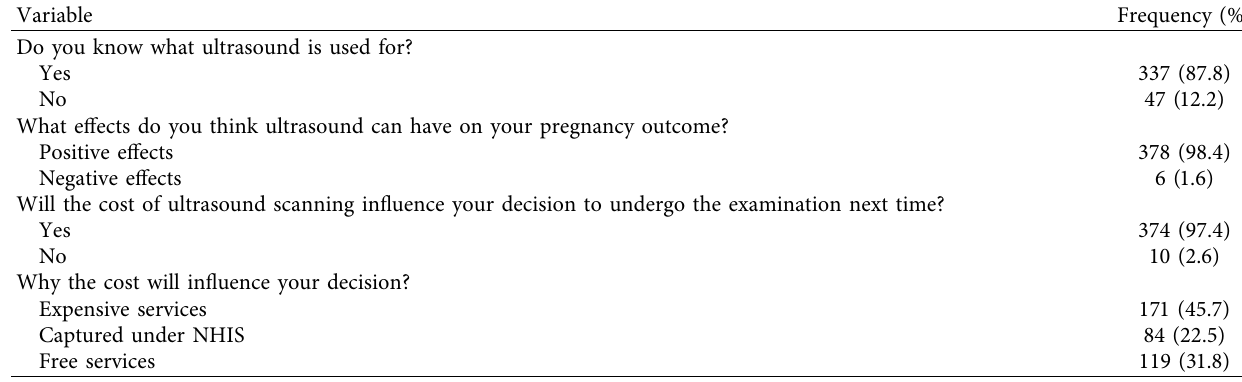
Table 3: Respondents views about obstetric ultrasound scans.